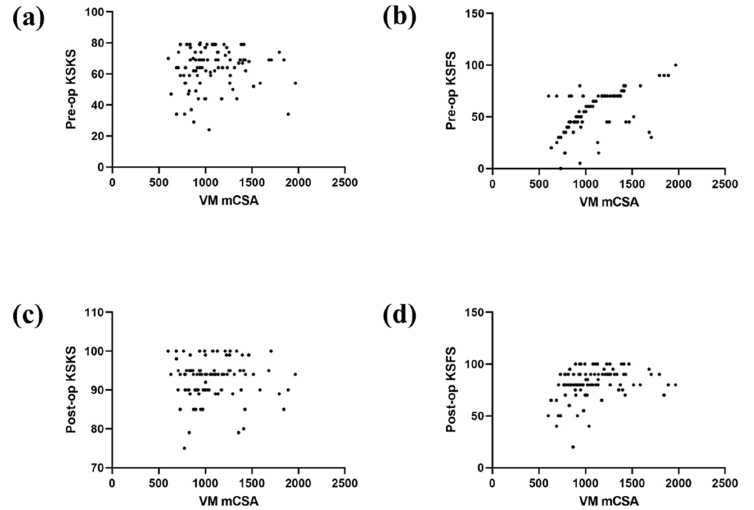
Figure 4. Scatter plots of the univariate relationship between CSA and ( a ) preoperative Knee Society knee score (KSKS); ( b ) preoperative Knee Society functional score (KSFS); ( c ) postoperative KSKS; ( d ) and postoperative KSFS.